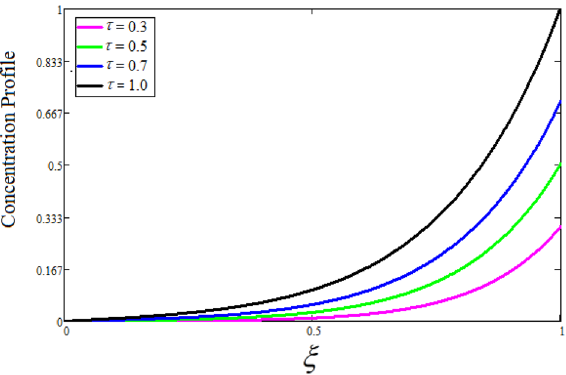
Figure 13. The consequence of Sc on the velocity distribution. Where R ζ M 5, k 0.3, Gr = =